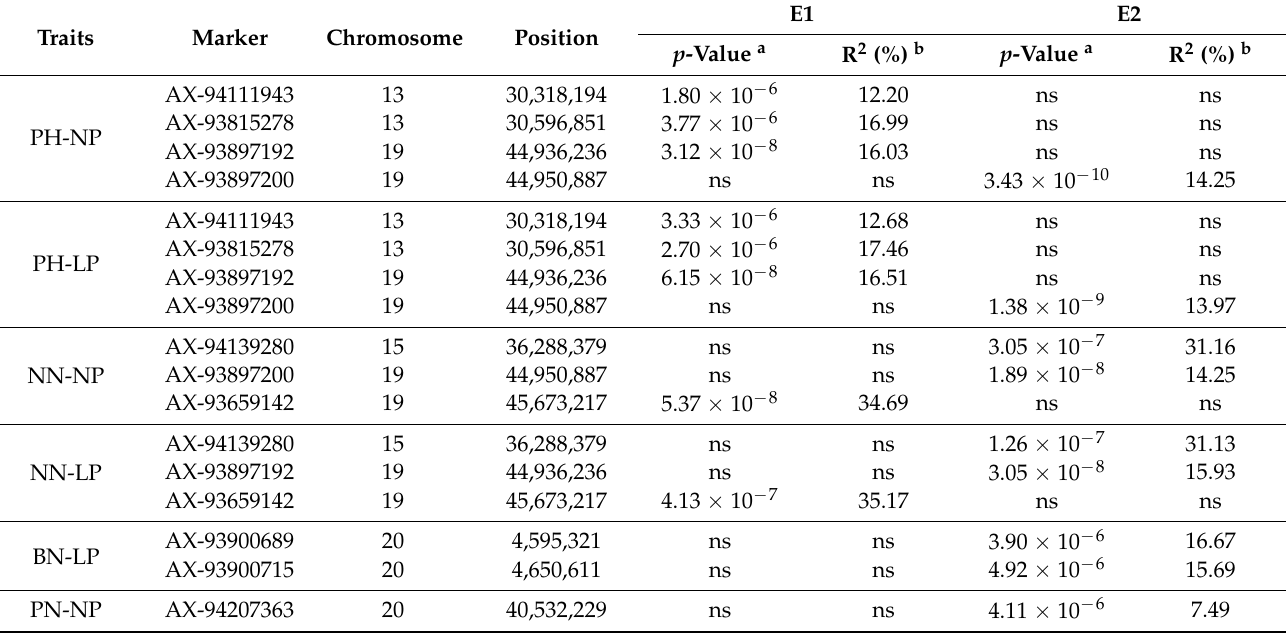
Table 3. SNPs significantly detected for the six soybean P-efficiency-related traits at maturity under NP and LP conditions in E1 and